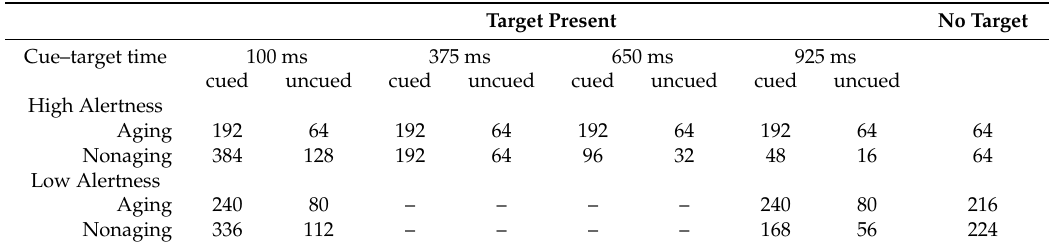
Table 1. Trial counts for all experimental